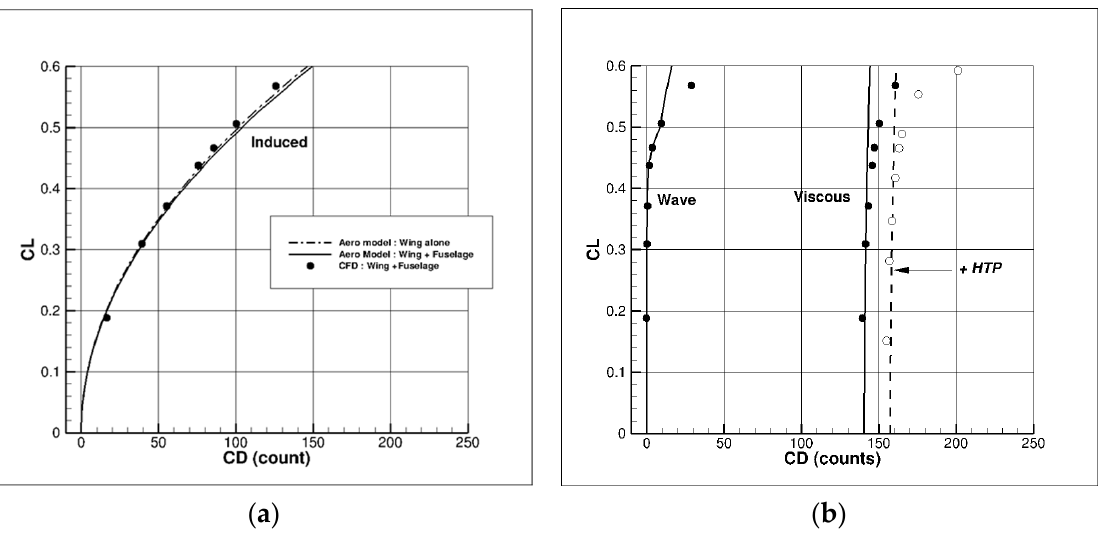
Figure 21. CRM configuration—drag components. Lines—aerodynamic module; symbols—CFD. ( a ) Lift-induced. ( b ) Wave and viscous.